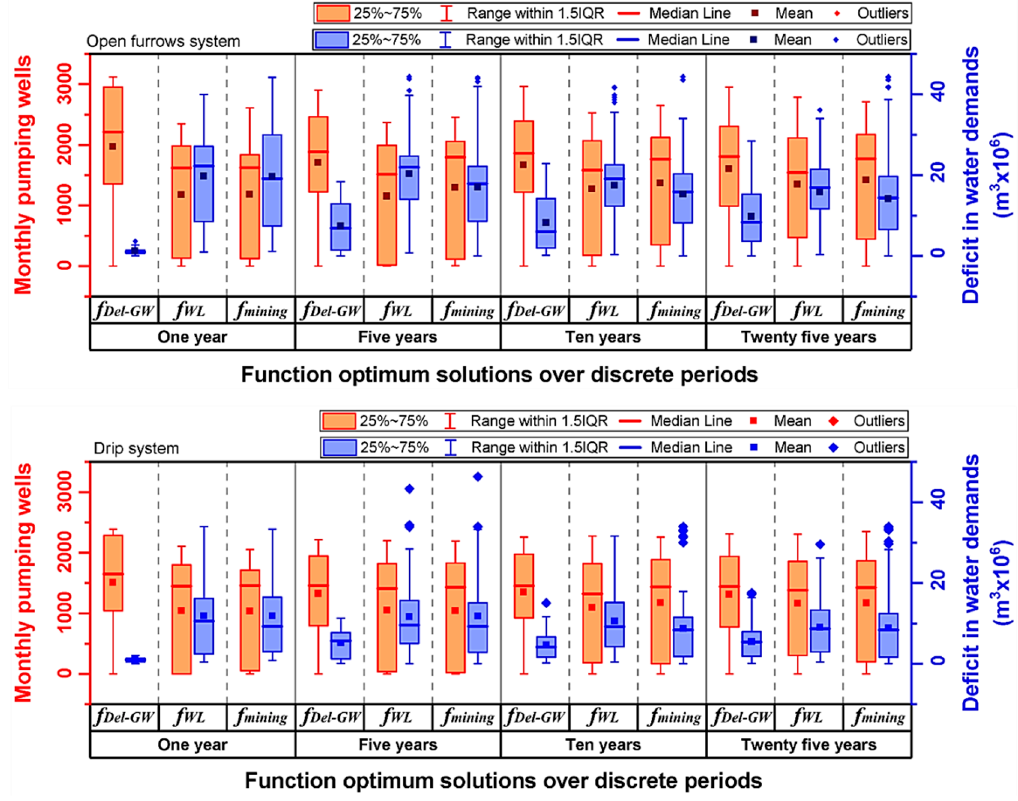
Figure 6. Number of wells and deficit in water demands achieved for both scenarios for discrete periods using optimization model. f Del-GW , f WL , and f mining refer to groundwater delivery, water losses, and mining objectives functions, respectively.